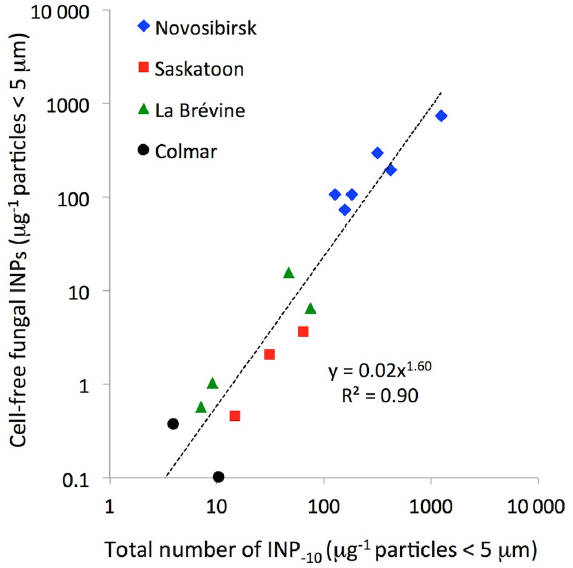
Figure 2. Cumulative freezing spectra of the (untreated) samples shown in Fig. 1 and a third sample from Colmar in which we could not detect INPs resembling macromolecules released by fungi (low- ermost